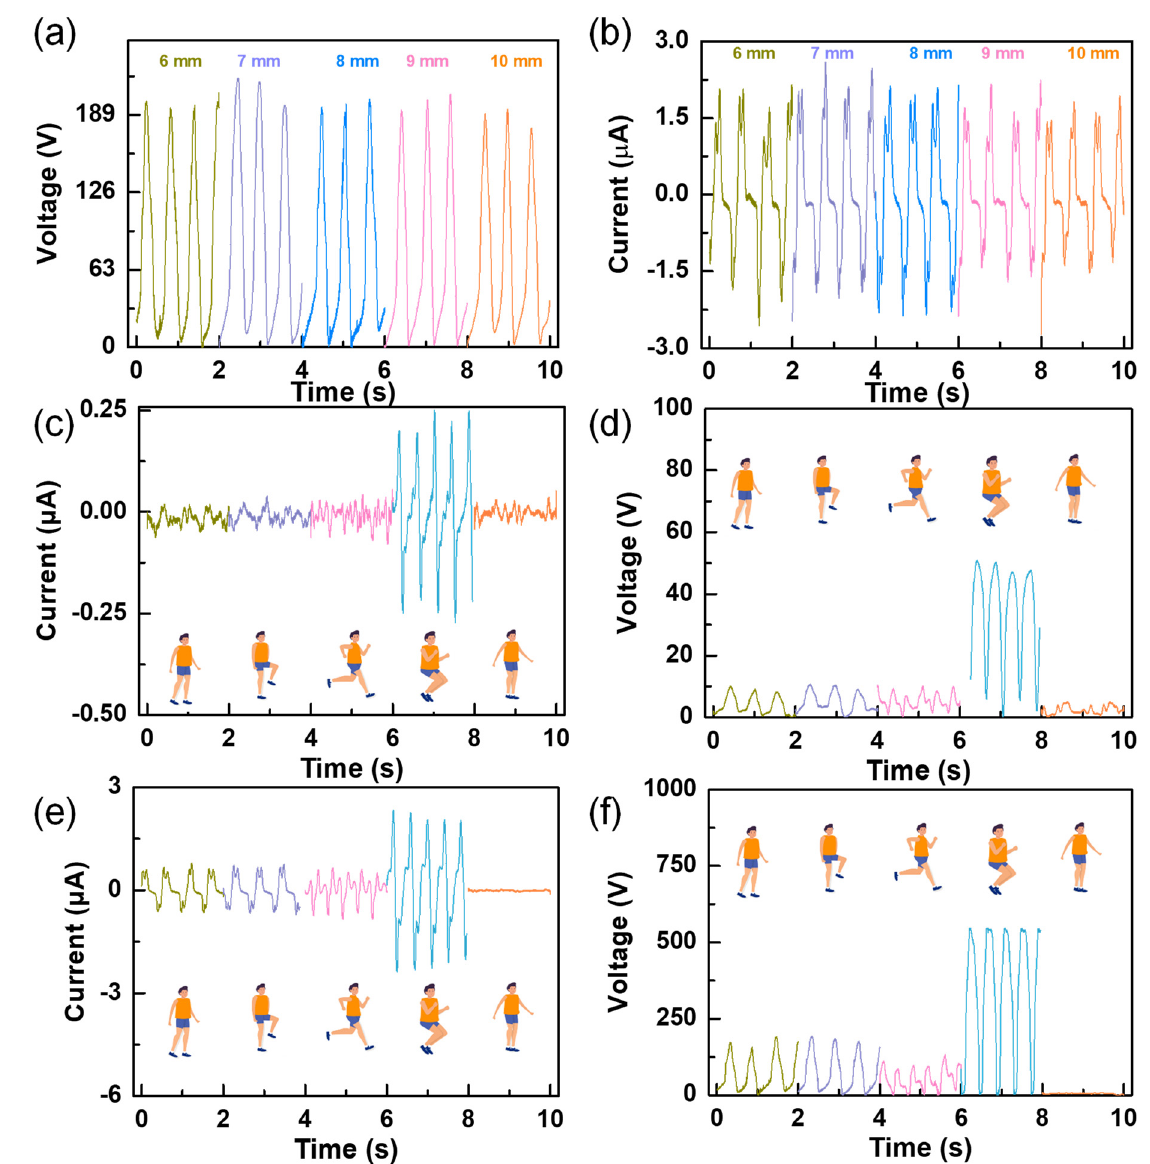
Figure 4. The influence of the diameter of the PTFE ball on the outputs and the outputs of the device under different motion modes: ( a ) the influence of the diameter of the PTFE ball on the output voltage; ( b ) the influence of the diameter of the PTFE ball on the output current; ( c ) the output voltages of W − TENG under different motion modes; ( d ) the output currents of W − TENG under different motion modes; ( e ) the output voltage of C − ENG under different motion modes; and ( f ) the output currents of C − ENG under different motion modes.